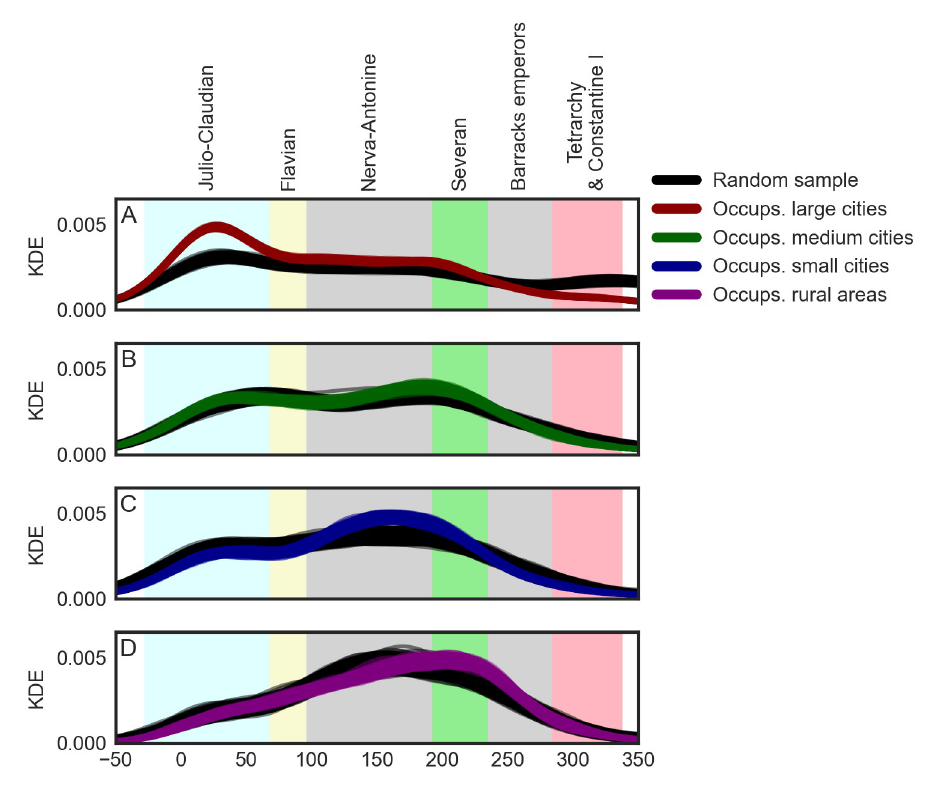
Fig 4. Temporal distributions of occupations using the KDE method and control